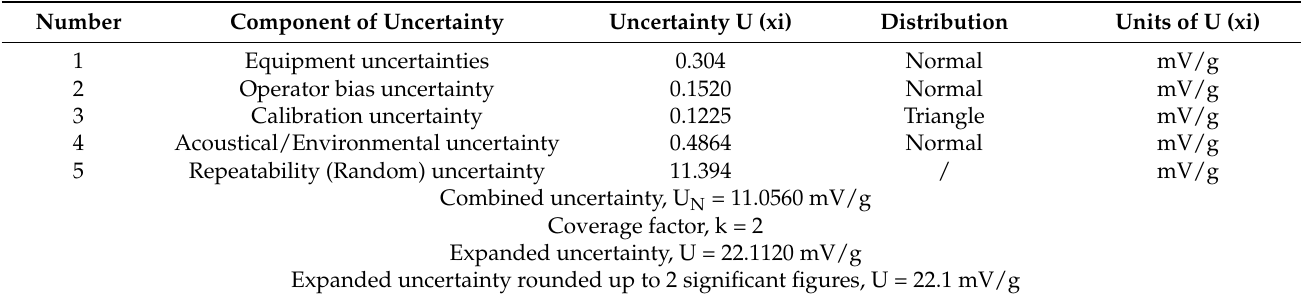
Table 4. The uncertainties budgets in the test.